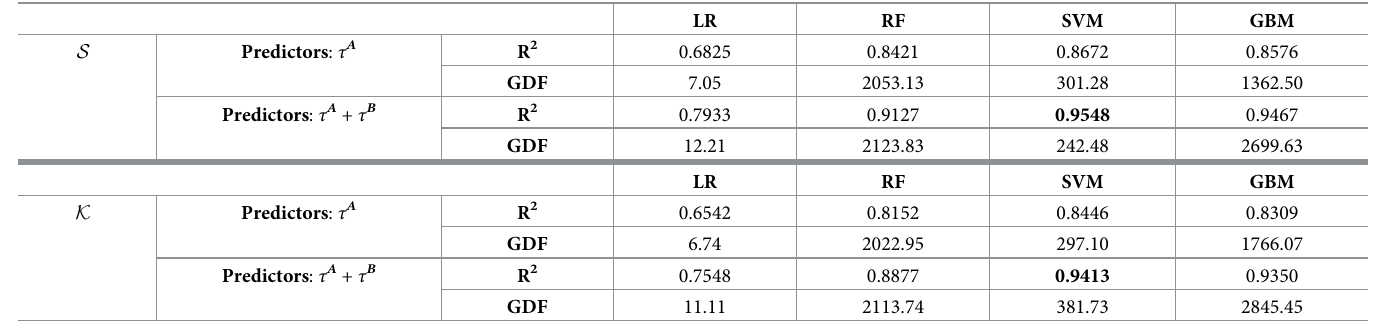
Table 4. R 2 and GDFs for the LR, RF, SVM and GBM procedures to predict S and K .